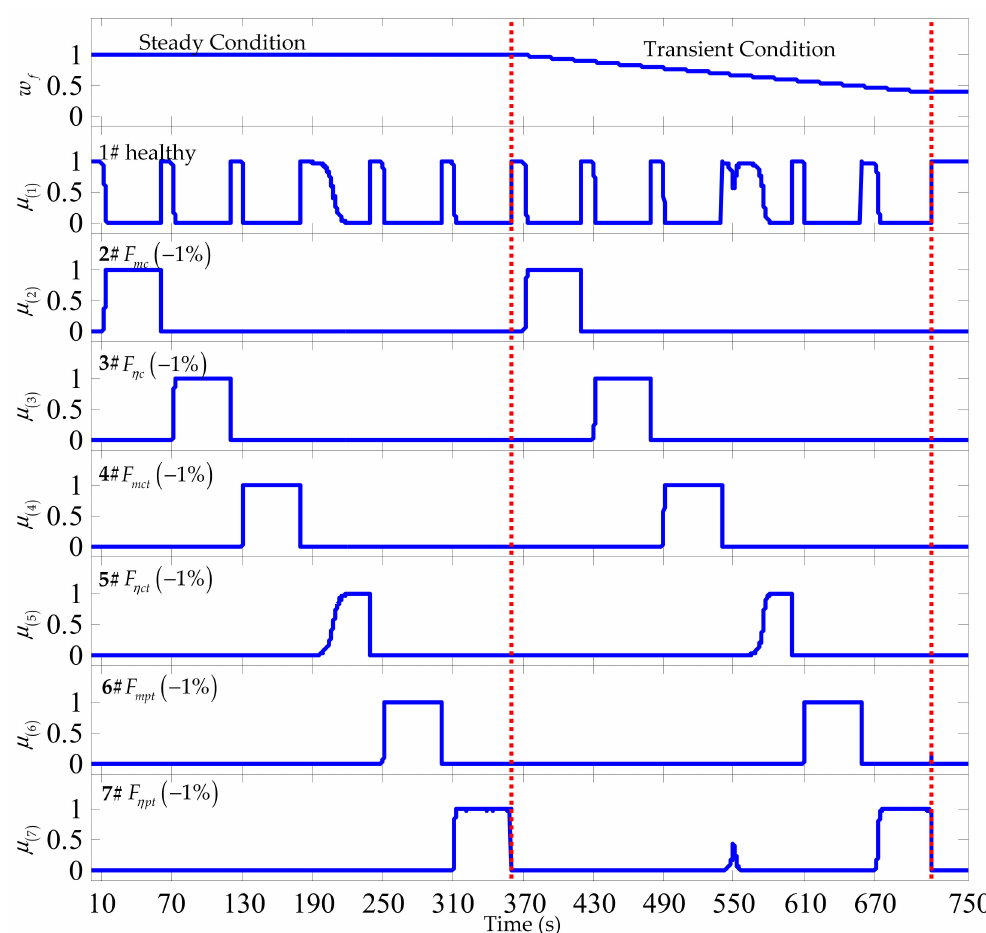
Figure 8. FDI result of a single gas path fault under the steady state condition and transient condition.